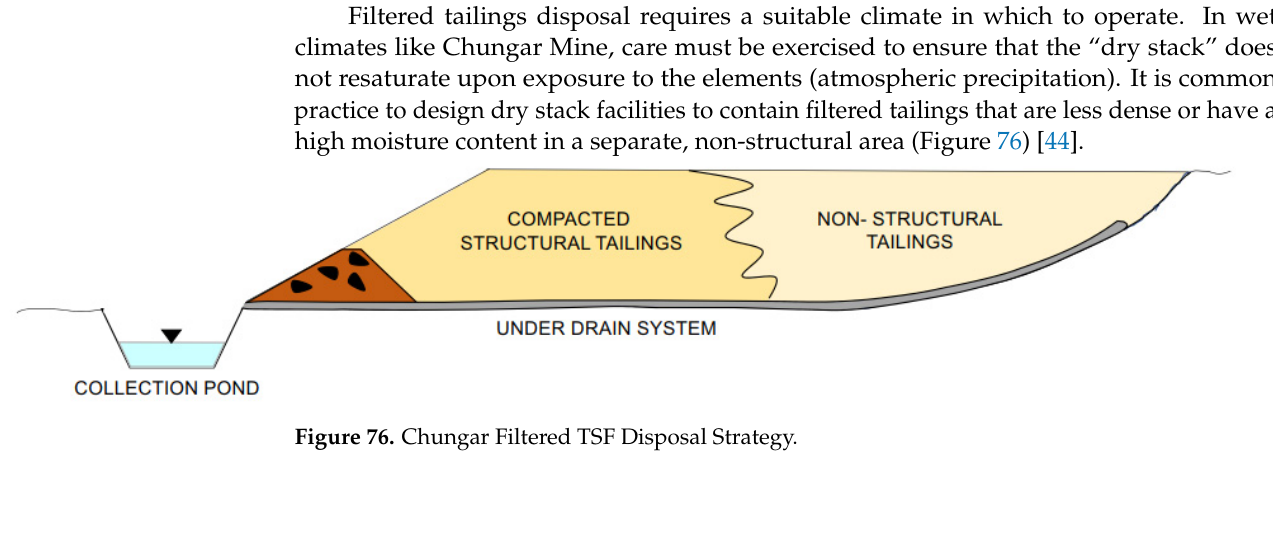
Figure 75. Chungar Tailings Filtering Plant.